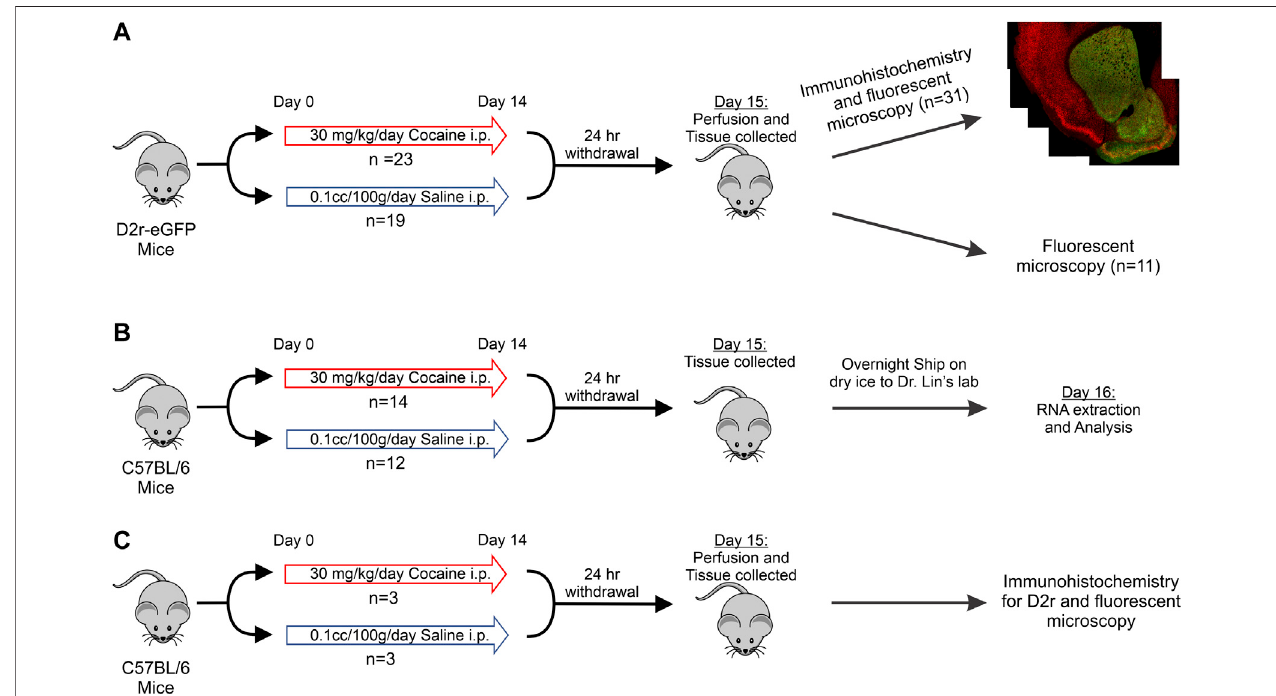
FIGURE 1 | Schematic of the experimental protocol and timeline. (A) : D2r-eGFP tissue collection with immunohistochemistry for eGFP and NeuN or no immunohistochemistryforeGFPintensityquanti fi cation; (B) :C57BL/6 tissue collection and mRNAanalysis; (C) : Drugtreatment,immunohistochemistry,andimagingof Drd2 in C57BL/6